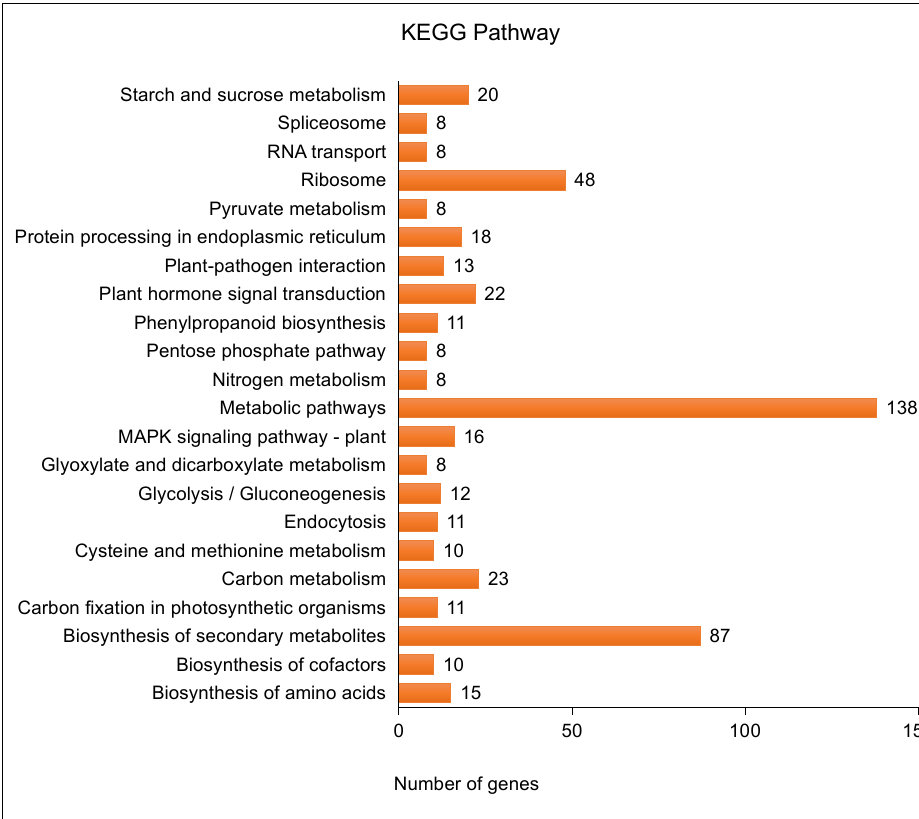
Figure 3. KEGG pathway analysis of DEGs in toluene treated and untreated A. pusilla .